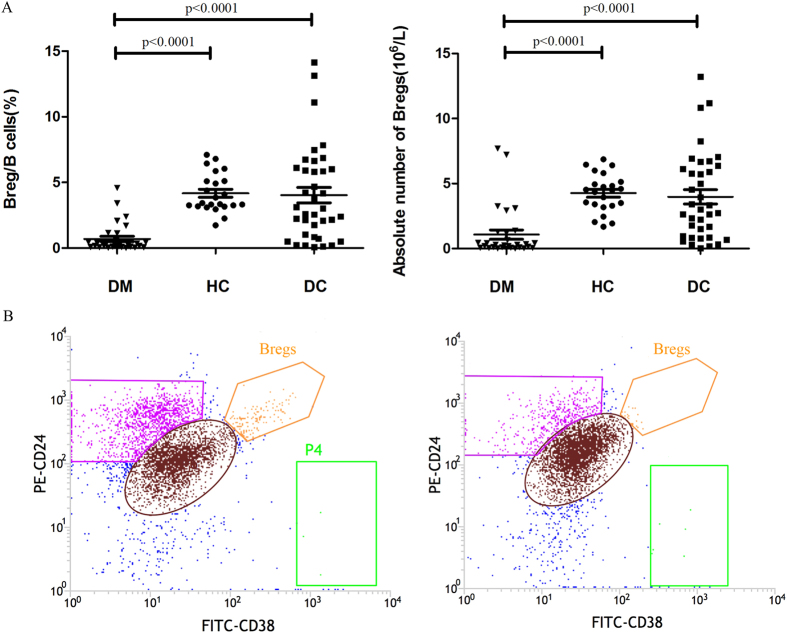
(A) The Breg levels among DM patients (n = 30), diseased controls (DC) (n = 37), and healthy controls (HC) (n = 23). The results were expressed by scatter dots plot depicting mean ± SEM. A significant decrease was observed in the frequency of CD19+ CD24highCD38high Bregs in DM patients compared to those in healthy controls (0.713 ± 0.275% vs 4.196 ± 0.347%, p < 0.0001) and in diseased controls (0.713 ± 0.275% vs 4.010 ± 0.566%, p < 0.0001) (A, left). The absolute number of Bregs was also significantly lower in DM patients than in healthy controls (1.079 ± 0.358 × 106 vs 4.267 ± 0.301 × 106, p < 0.0001) and diseased controls (1.079 ± 0.358 × 106 vs 3.981 ± 0.551 × 106, p < 0.0001) (A, right). (B) Representative cases of a healthy control (B, left) and of a DM patient (B, right).